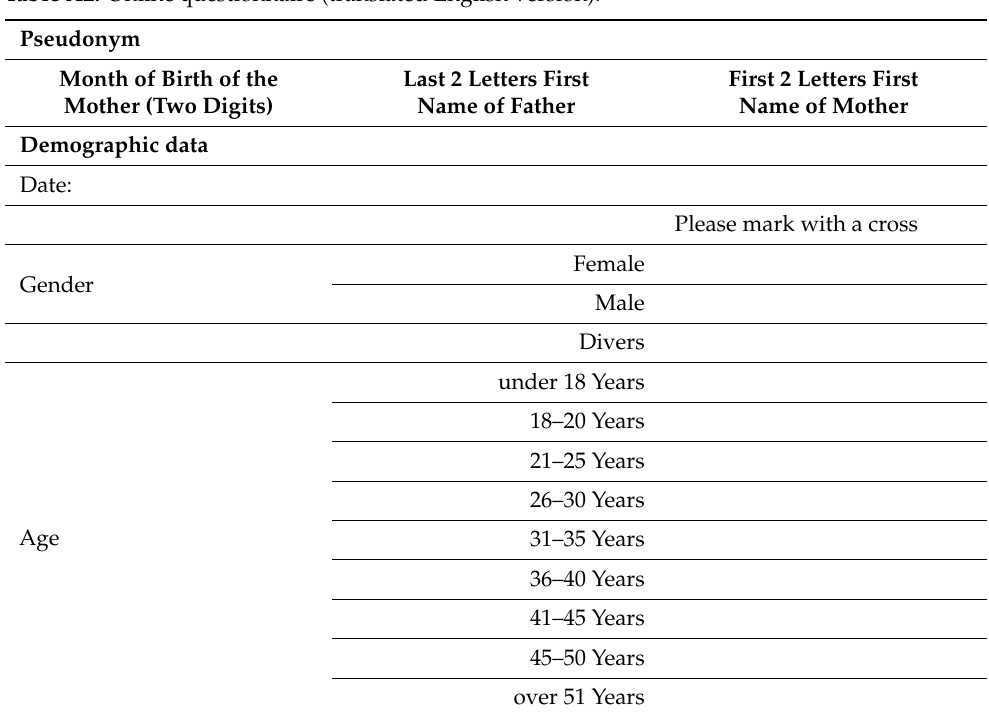
Table A2. Online questionnaire (translated English